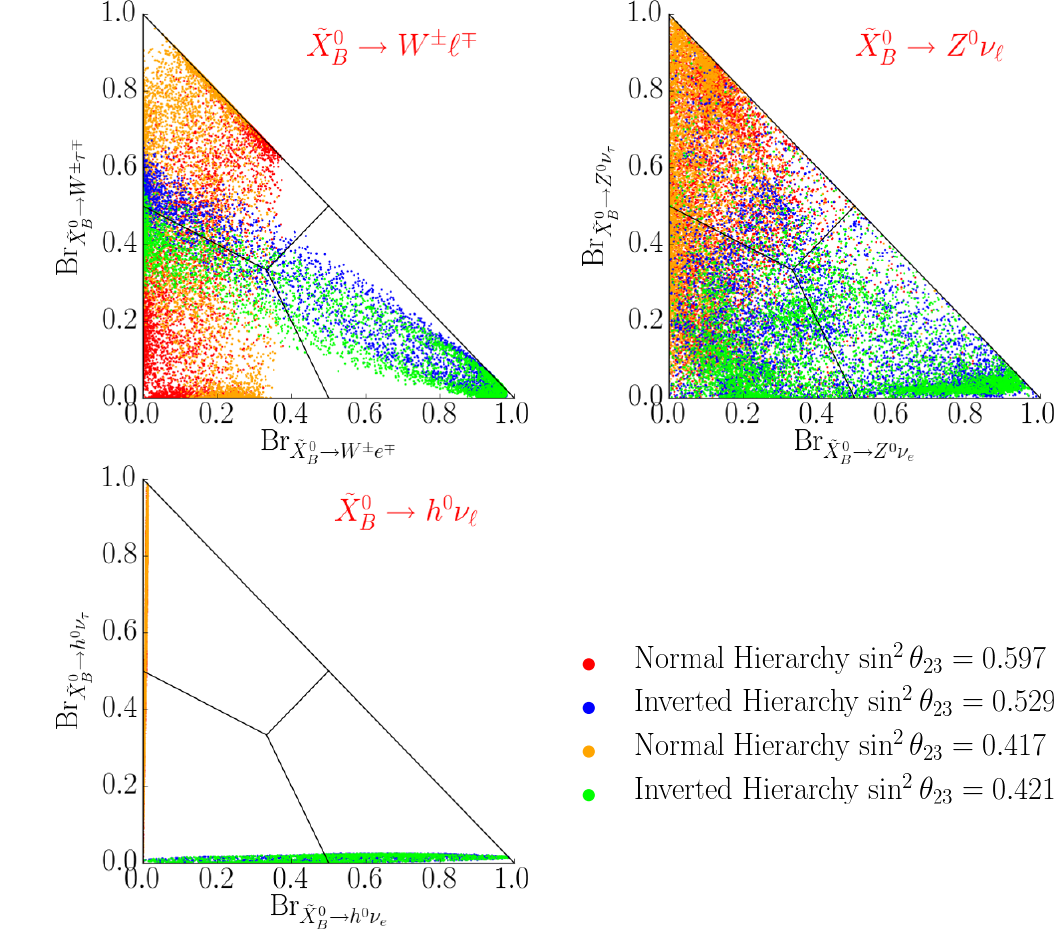
Figure 8. Branching ratios into the three lepton families, for each of the three main decay channels of a Bino neutralino LSP. The associated neutrino hierarchy and the value of (cid:18) 23 is speci(cid:12)ed by the color of the associated data